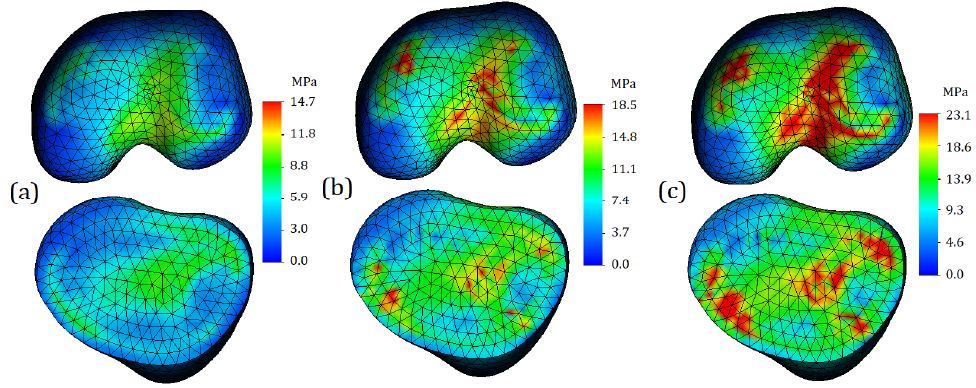
Figure 12. Von Mises stress plots on contact surfaces of the bones in case of running: ( a ) With mild cartilage sti ff ness; ( b ) With moderate cartilage sti ff ness; ( c ) With severe cartilage sti ff ness.